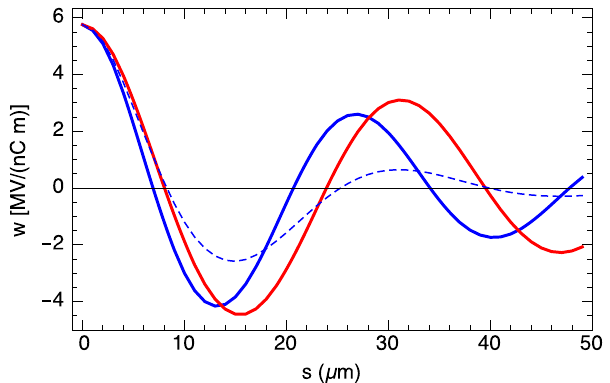
FIG. 2. The wake of the point charge for copper (red) and aluminum (blue) pipes. The dashed blue line shows the wake for the case when the aluminum pipe is at room temperature (no